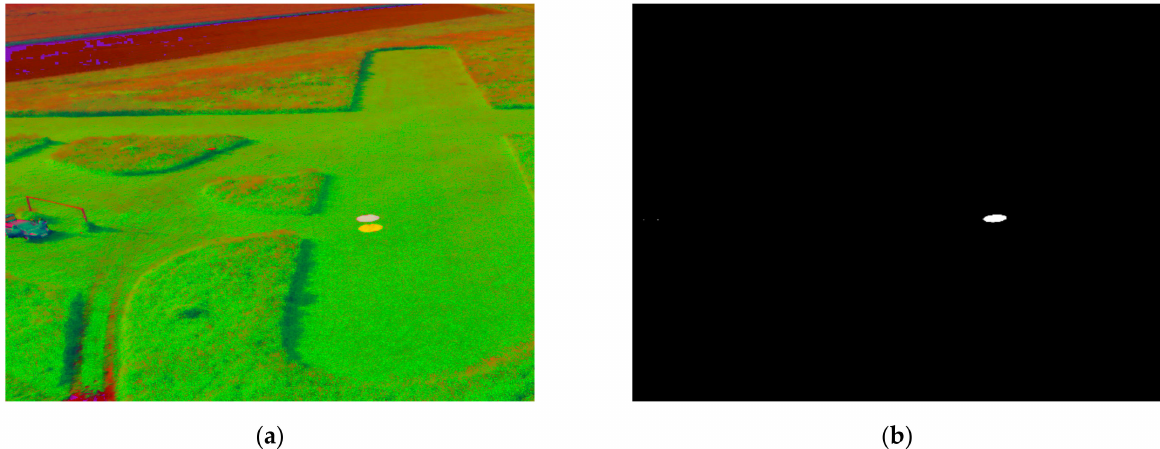
Figure 6. ( a ) Picture converted into HSV model of color. ( b ) Post-binary-operation monochromatic picture for yellow